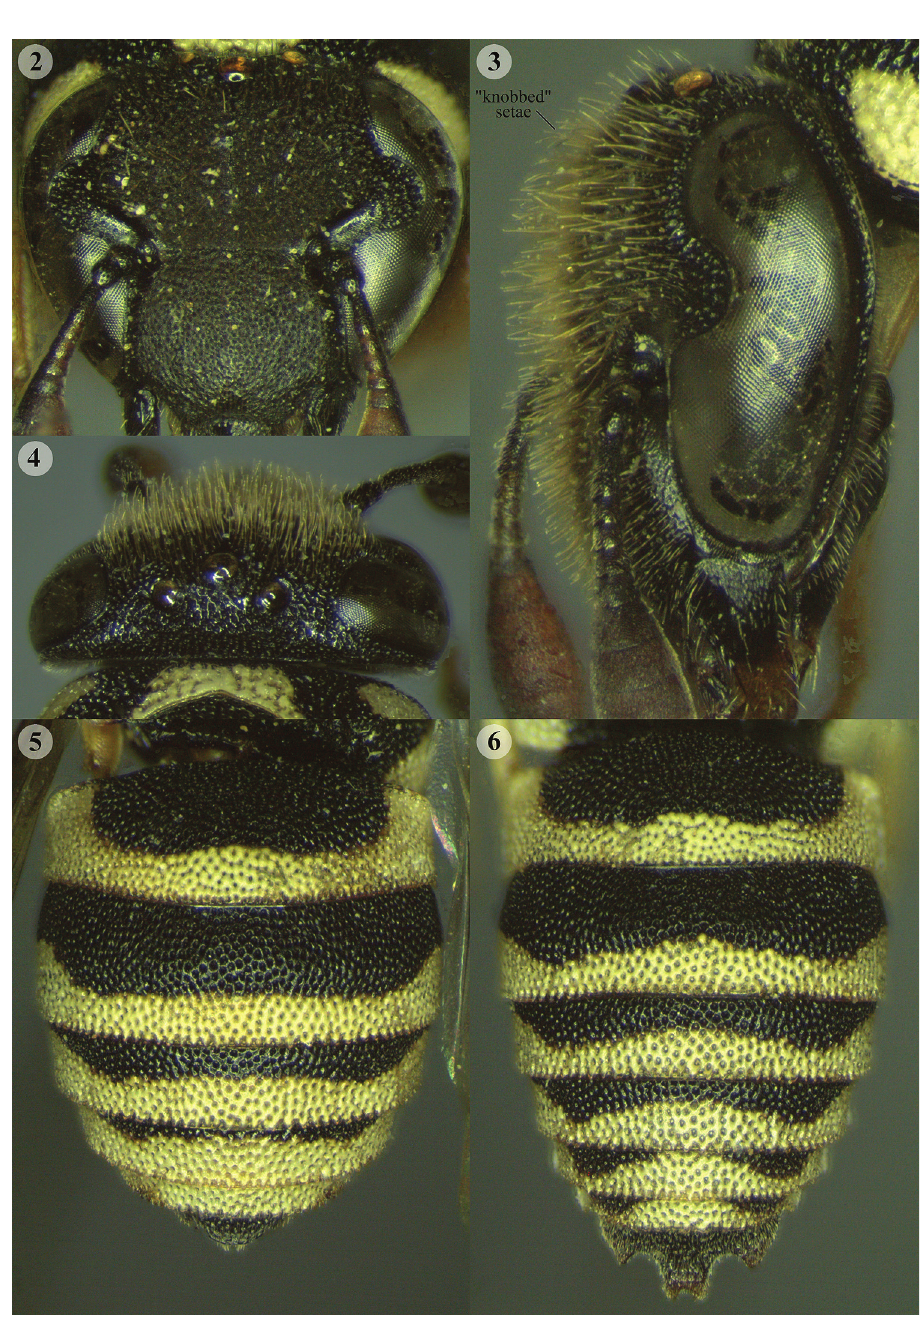
Figures 2–6. Head of female of Celonites hermon (dbM No. 3685) 2 in frontal view 3 in lateral view show- ing pollen collecting apparatus with “knobbed” setae on frons and clypeus 4 in dorsal view 5–6 Metasoma of Celonites hermon in dorsal view 5 female (dbM No. 3685) 6 male (dbM No.